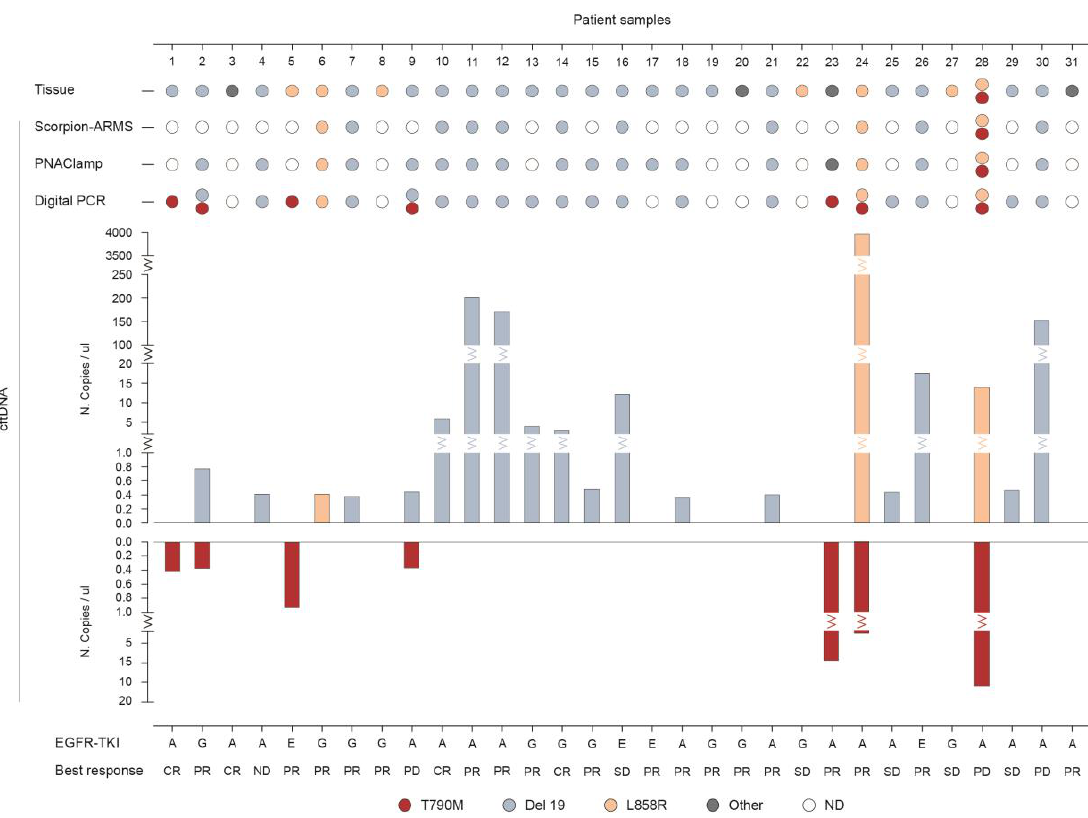
Figure 2. Comparison of the three methodologies in detecting EGFR mutations in plasma versus tissue analysis. EGFR mutations as detected in liquid biopsy at baseline through cell-free tumor DNA (cftDNA) analysis by Scorpion-ARMS EGFR Plasma RGQ PCR Kit-QIAGEN, PNAClamp EGFR -PANAGENE, and QuantStudio 3D Digital PCR System-Thermo Fisher Scientific. Mutational analysis of EGFR in plasma samples is compared to tissue biopsies ( n = 31; ND, not determined). The number of mutated EGFR copies obtained by QuantStudio 3D Digital PCR is indicated as copies/ul. Results are presented along with the type of anti-EGFR treatment and clinical response (TKI, Tyrosin Kinase Inhibitor; A, Afatinib; G, Gefitinib; E, Erlotinib; CR, Complete Response; PR, Partial Response; SD, Stable Disease; PD, Progressive Disease).